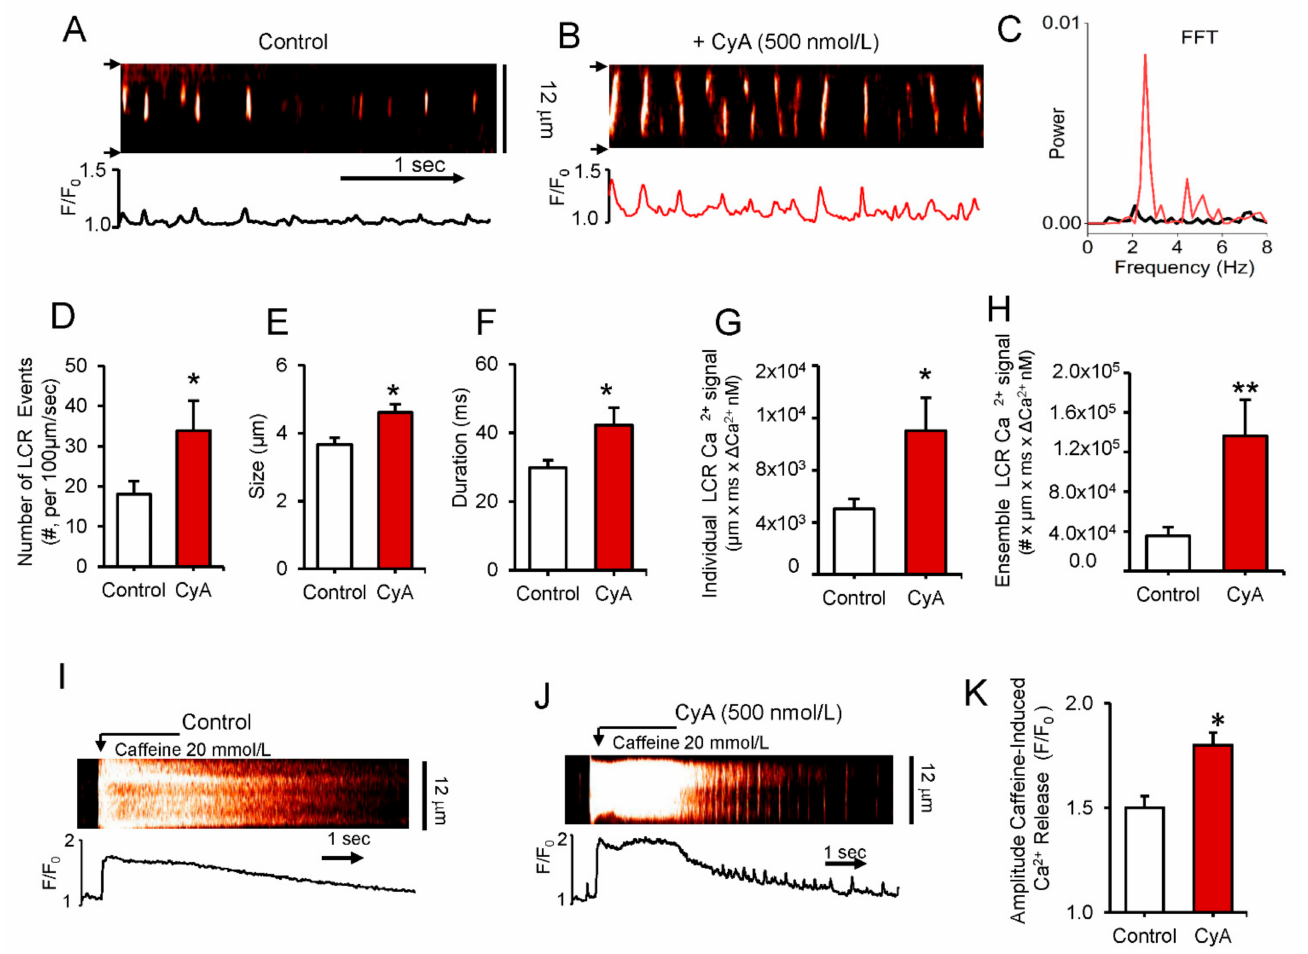
Figure 4. ( A , B ) Representative confocal line-scan images and ( C ) a fast Fourier transform (FFT) of Ca 2+ oscillations in a permeabilized SANC bathed in 150 nmol/L [Ca 2+ ] in control conditions and during superfusion with 500 nmol/L CyA. ( D – H ) Average changes in local Ca 2+ release characteristics (LCRs) in control and during superfusion with 500 nmol/L CyA ( n = 6): ( D ) Number of LCR events per 100 µ m of the line-scan image and during a 1-sec time interval; ( E ) LCR size (as FWHM, the full width at half-maximum amplitude); ( F ) LCR duration (as FDHM, the full duration at half-maximum amplitude); ( G ) Ca 2+ signals of Individual LCRs ( µ mxmsx ∆ Ca 2+ nmol/L); ( H ) Ca 2+ signals of the LCR ensemble (the integrated Ca 2+ signal of all LCRs), * p < 0.05, ** p < 0.01 paired t -test vs control, n = 6. Representative confocal images ( I , J ) and the average amplitude of the SR Ca 2+ release ( K ) induced by a rapid spritz application of 20 mM caffeine in permeabilized SANC during 500 nmol/L CyA superfusion ( n = 12) and in control ( n = 7). * p < 0.05, 2-tailed t